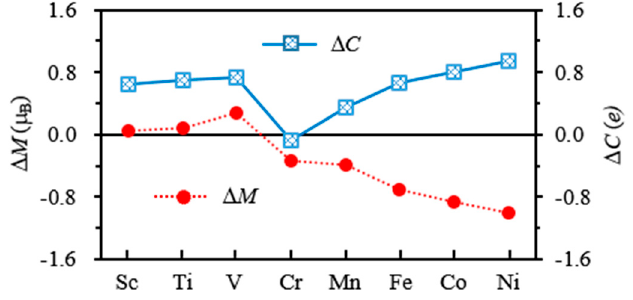
Figure 11. The change of magnetic moment ( Δ M ) and the charge transfer ( Δ C ) of 3 d orbital of M atom in Cu 4 M (M = Sc-Ni) clusters.